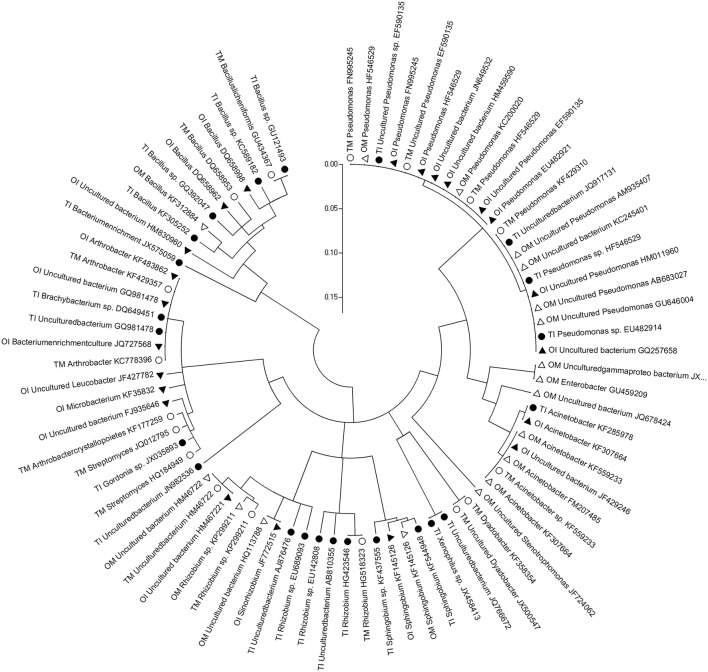
Phylogenetic analysis based on partial bacterial 16S rDNA sequence derived from the PSB of rhizosphere soil of tomato and potato onion grown as monocrops and intercrops at 37 DAT. Distances and clustering with the neighbor-joining method was performed by using the molecular evolutionary genetics analysis software version 4.0. TM, tomato monoculture(•); TI, tomato intercropping with potato onion(•); OM, potato onion monoculture(Δ); OI, potato onion intercropping with tomato(▴).